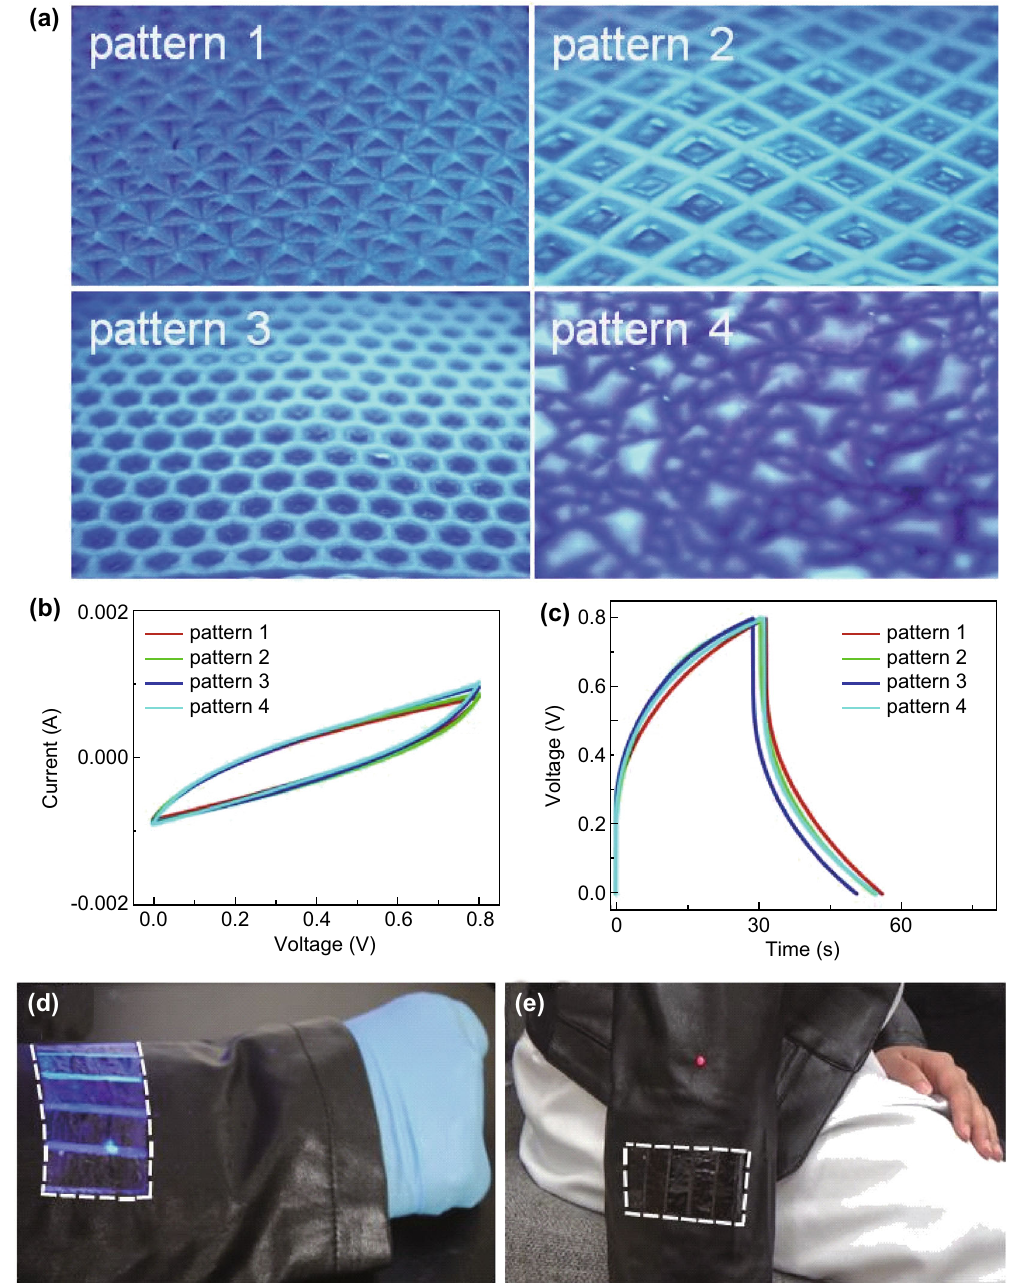
Fig. 4 a Fluorescent miwPU artificial leathers with various patterns. b CV curves of patterned miwPU artificial leather supercapacitors. c GCD curves of patterned miwPU artificial leather supercapacitors. d The fluorescent supercapacitor sleeve under excitation. e The supercapacitor sleeve powering a light-emitting